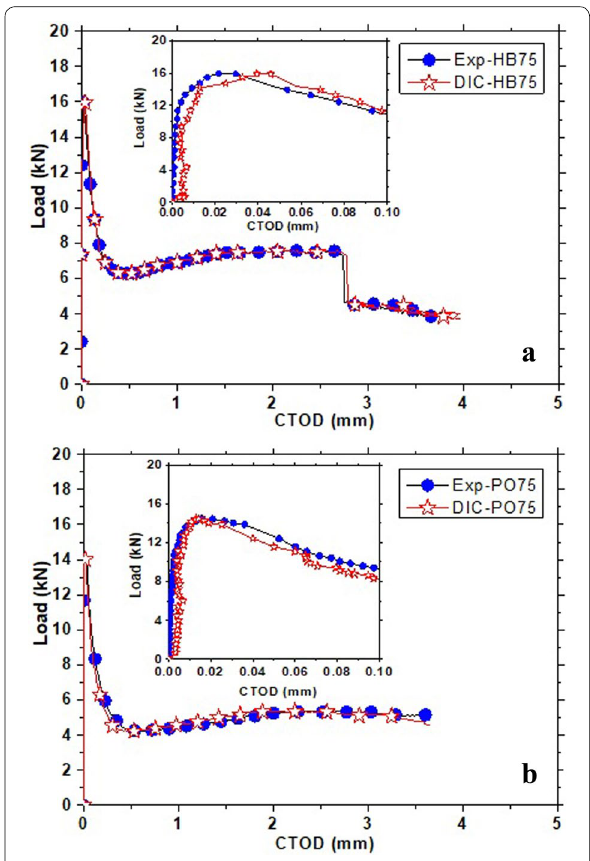
Fig. 7 Comparison of DIC results with experimental results from clip gauge readings for CTOD: a HB75 beam, b PO75 beam.